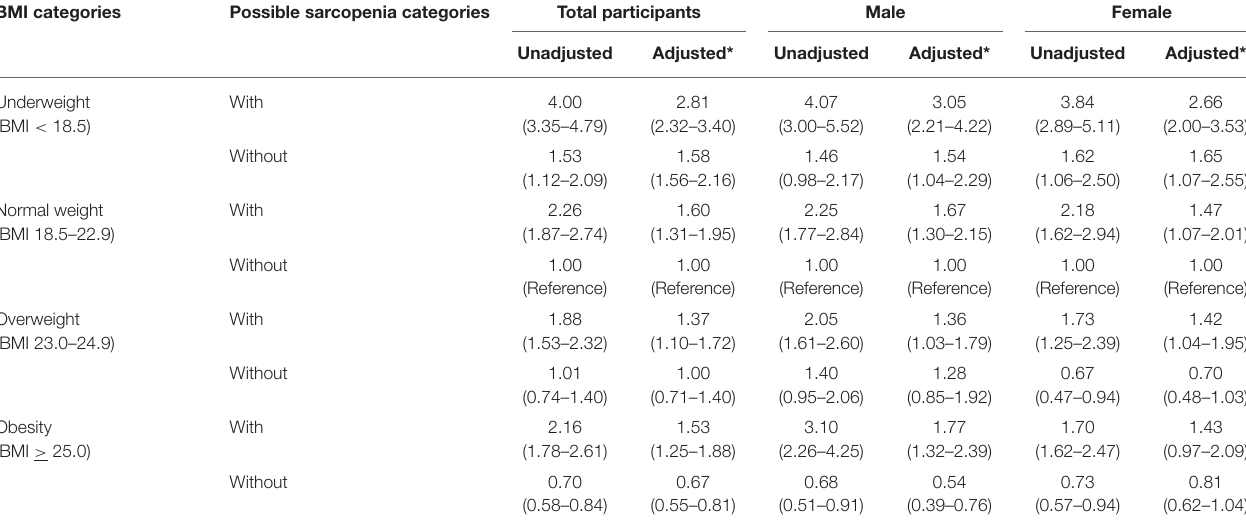
TABLE 3 | Association between 10-year all-cause mortality and body mass index (BMI) category stratified by possible sarcopenia status for all study participants, and compared between male and female Thai older adults who participated in the 4th Thai National Health Examination Survey (NHES-IV) ( N =